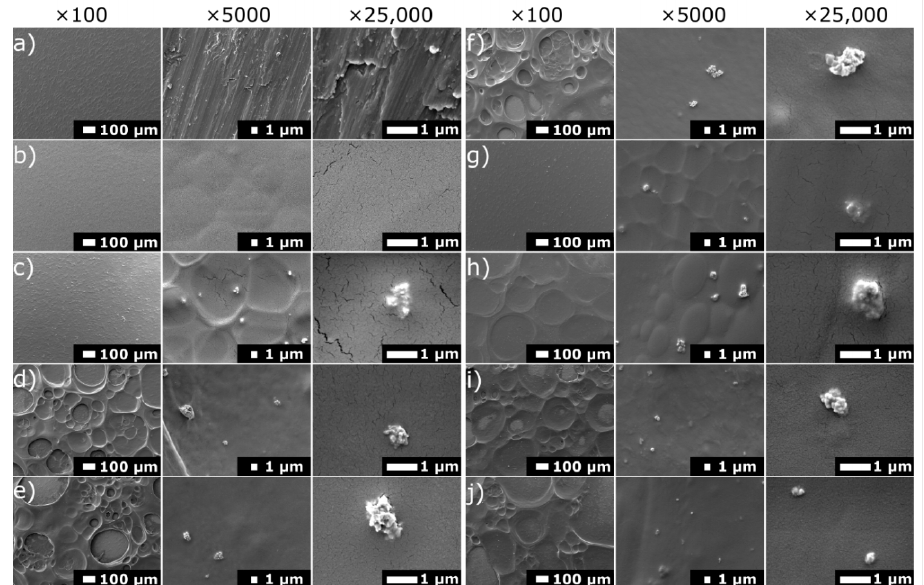
Figure 1. SEM images of the surface of ( a ) titanium substrate, ( b ) chit/EE100 coating, and the chit/EE100/AgNPs coatings prepared with various process parameters: ( c ) A1, ( d ) A3, ( e ) A1 (cid:48) , ( f ) A3 (cid:48) , ( g ) B1, ( h ) B3, ( i ) B1 (cid:48) , ( j ) B3 (cid:48) sample.